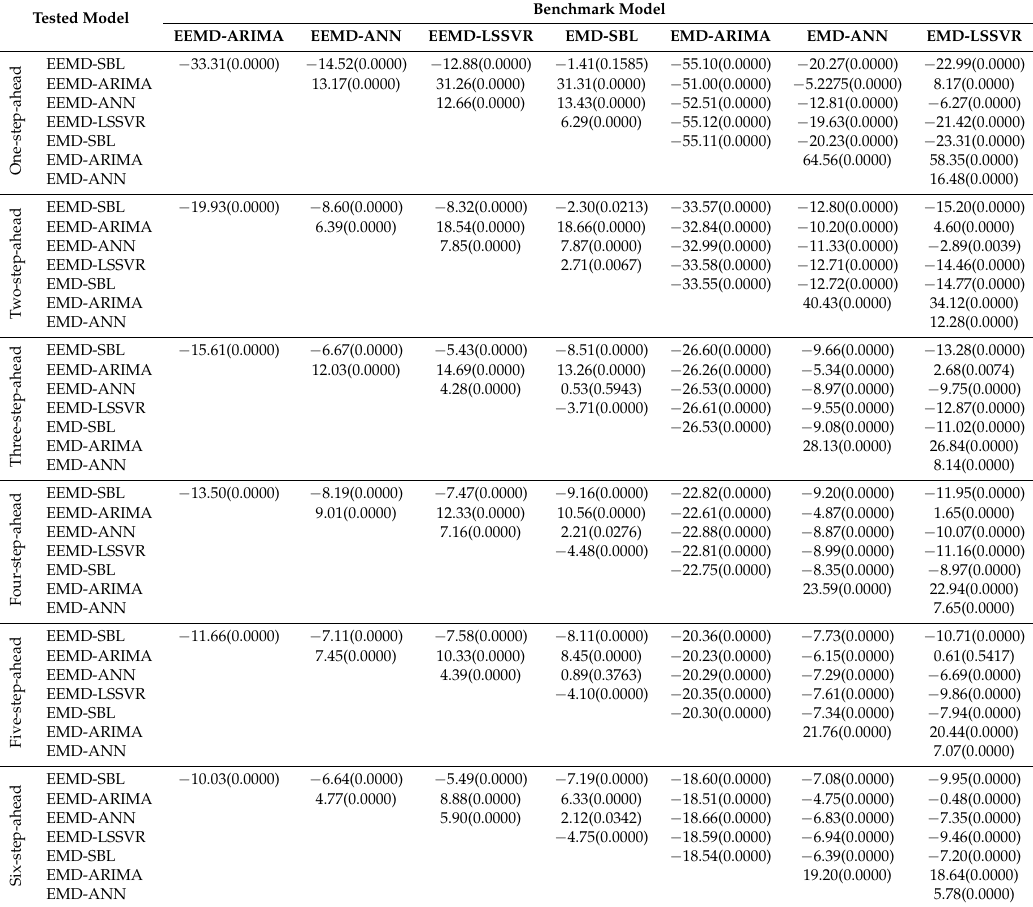
Table 11. DM test results for ensemble models on Brent crude oil